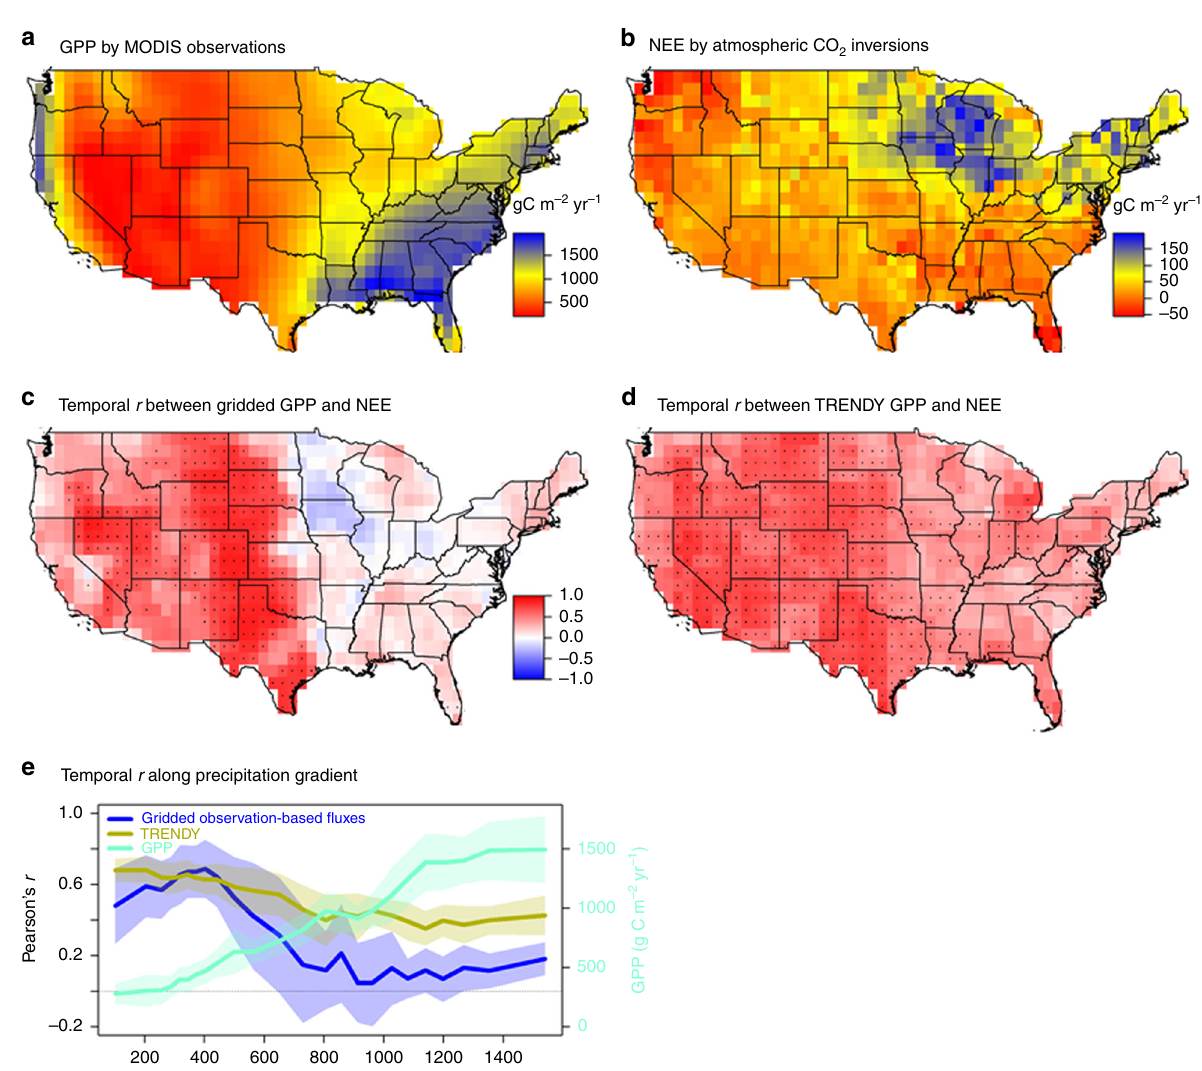
Fig. 1 Relationship between production and net ecosystem carbon exchange along the precipitation gradient. Relationship between estimates of GPP (gross primary production) constrained by MODIS (Moderate Resolution Imaging Spectroradiometer) satellite observations and NEE (net ecosystem carbon exchange) constrained by atmospheric measurements in inversions varies along the precipitation gradient in the contiguous United States (CONUS). The spatial pattern of mean annual GPP ( a , MOD17 GPP, 2000 – 2014) and NEE ( b , ensemble mean from four atmospheric CO 2 inversion models between 2000 and 2014, a positive value indicates land as carbon sink) in the CONUS. c Mean temporal Pearson ’ s r between gridded observation-based GPP estimates ( n = 4) and gridded NEE estimates ( n = 2) between 2000 and 2014 (Supplementary Fig. 3). Dots indicate that correlation is signi fi cant if greater than four individual combinations are signi fi cant at 0.1 level in Supplementary Fig. 3. d Mean temporal Pearson ’ s r between modeled GPP and NEE by ten dynamic global vegetation models (DGVMs) from TRENDY project between 2000 and 2010 (Supplementary Fig. 15). Dots indicate a correlation is signi fi cant if more than fi ve individual DGVM is signi fi cant at 0.1 level in Supplementary Fig. 15. e Mean Pearson ’ s inter-annual r between detrended GPP and NEE along the precipitation (and GPP) gradient in the CONUS, suggesting precipitation as the dominant control on GPP variations and GPP is the primary control on the inter-annual variation of NEE. Shaded areas are the mean ± one standard deviation within each precipitation bin. a – d were created in the R environment for statistical computing and graphics